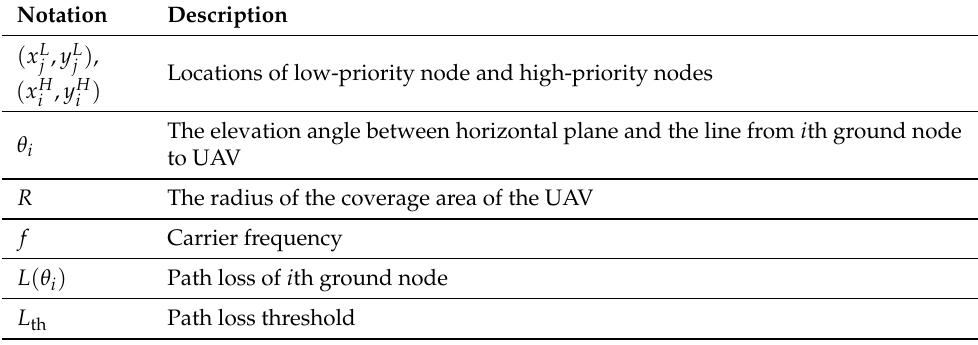
Table 2. Mathematical notations used in this